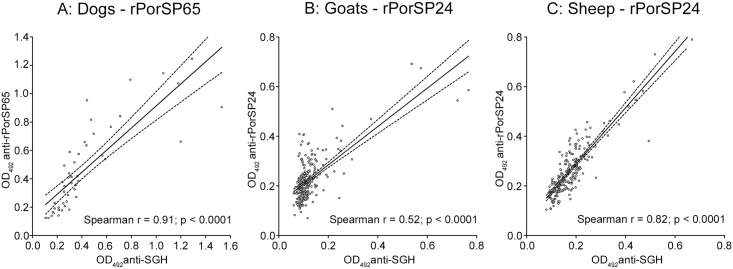
Correlation analyzes between IgG antibodies against SGH and recombinants rPorSP65 and rPorSP24 in ELISA.For each animal species from validation experiments (Fig 3), the protein with the highest positive correlation was displayed: A: rPorSP65 (ParSP25-like protein) tested with canine sera (n = 50), B: rPorSP24 (yellow-related protein) tested with goat sera (n = 248), C: rPorSP24 (yellow-related protein) tested with sheep sera (n = 209). Sera from naturally-exposed Ethiopian animals together with sera from non-exposed controls were included in this analysis. Correlation coefficients and p-values from Spearman-Rank analysis are indicated.